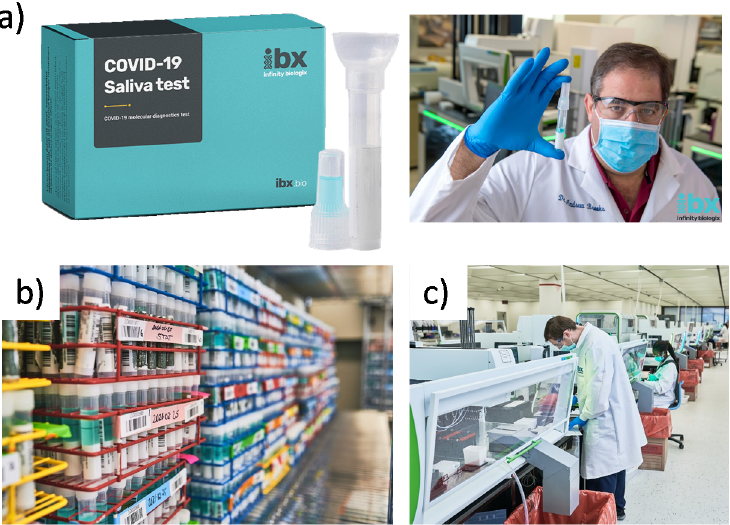
Figure 8. Demonstration of the manufacturing and testing facilities for laboratory processing, data storage, sample preservation, and analytical processes at IBX Infinity Biologix. ( a ) IBX Saliva Collection Kit. ( b ) A repository for cryo-preserving and storing a vast number of biological samples and consumables. ( c ) Automated instrumentation for sample purification, precision liquid handling, viral nucleic acid extraction and testing, Next Generation Sequencing, and analytical quality control. Images are reproduced and adapted with permission from IBX Infinity Biologix [26].